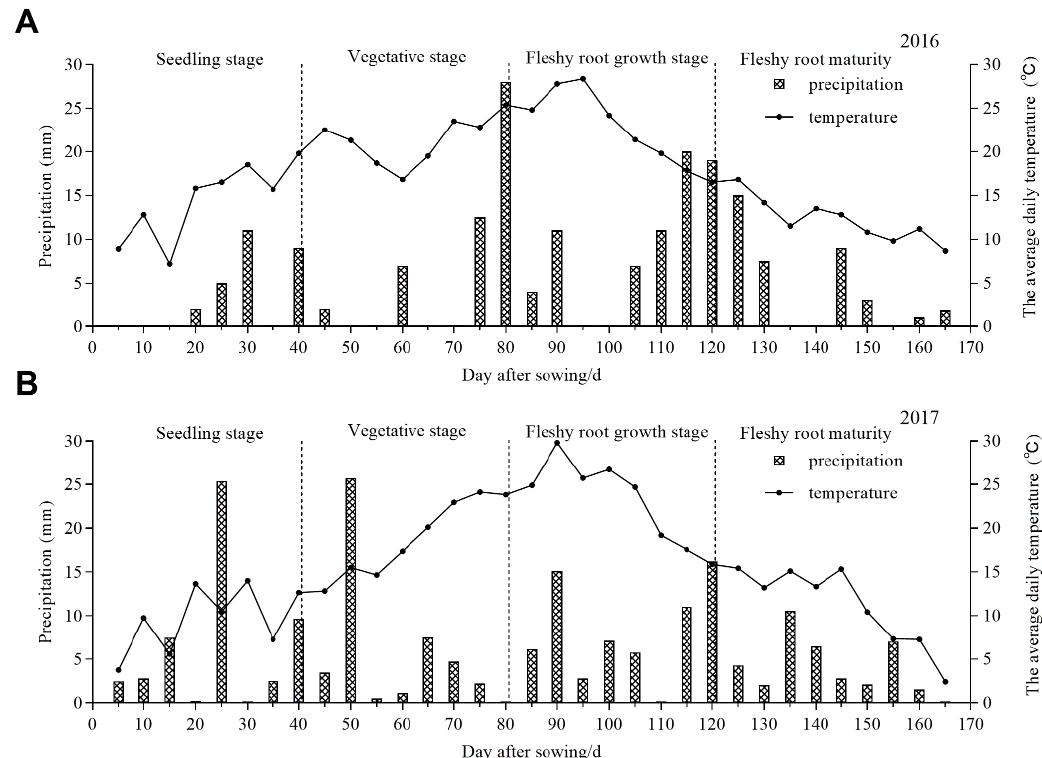
Figure 1. Average temperature and precipitation changes during different growth stages. ( A ) The experimental data in 2016. ( B ) The experimental data in 2017.